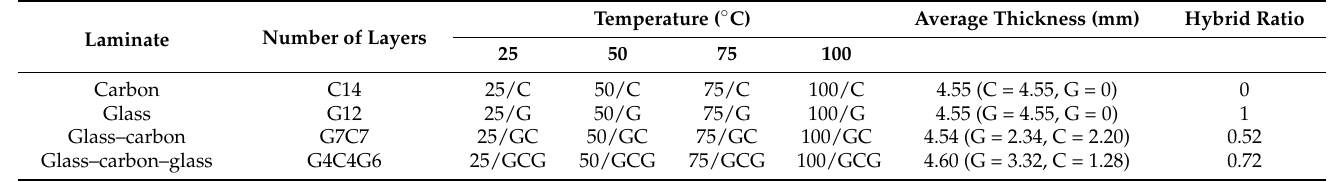
Figure 2. Orientations and stacking sequences of carbon, glass, and hybrids of the two fibres. Table 2. Designation of hybrid and non-hybrid laminates tested at different